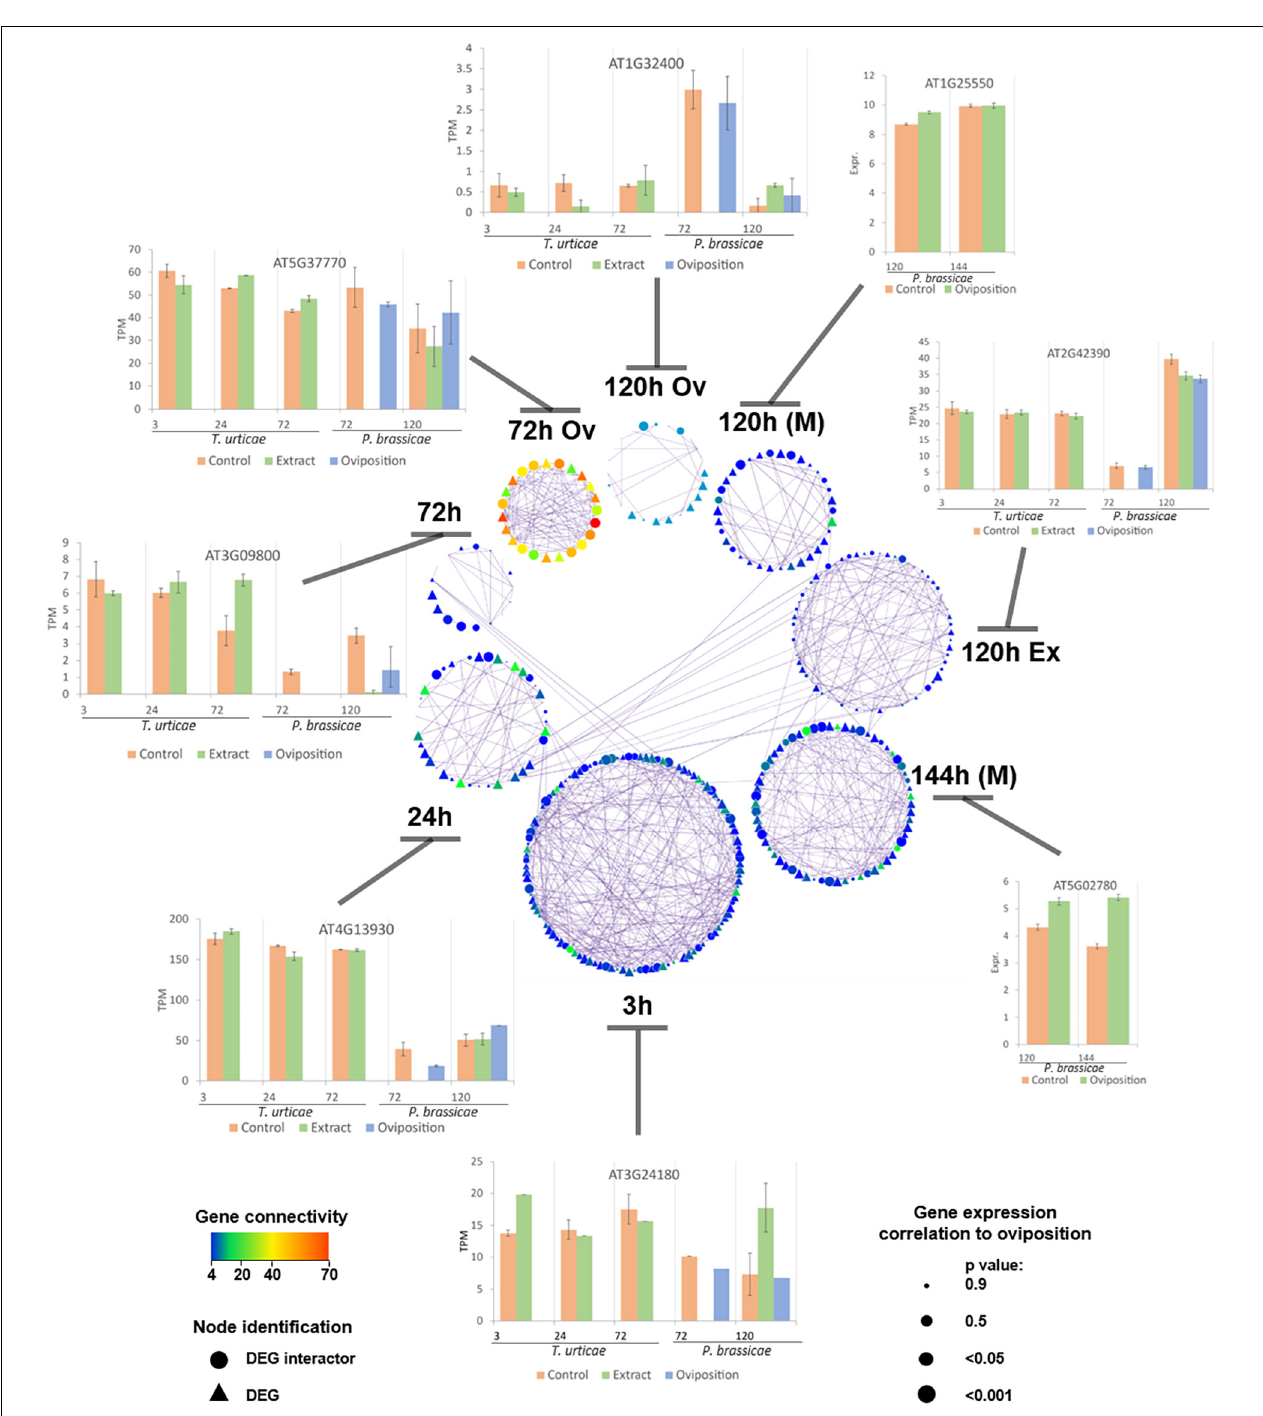
FIGURE 5 | Protein–protein interaction network representing DEGs and interactors from the modules correlated to the oviposition stress. Co-expression among components of the current network is identified by lines (edges). A representation of the transcript per million (TPM) behavior of some of the key regulators per experiment is depicted. Columns represent means and bars the standard error of the mean (SEM). Node size increases when the p -value of the correlation between the gene and the experiment decreases. Color indicates connectivity, being red more connected and blue less connected genes. Genes having less than three connections were not represented on this network. Nodes represented as triangles correspond to DEGs and circles to their co-expressed interactors. Each time point represents the results of a study, from the bottom and clockwise: 3–72 h, T. urticae egg extract; 72 h Ov, P. brassicae oviposition; 120 h Ov, P. brassicae oviposition; 120 h (M), P. brassicae oviposition; 120 h Ex, P. brassicae egg extract; 144 h (M), P. brassicae oviposition. Microarray results are identified by an (M), the rest of the results were obtained from RNA-seq data.